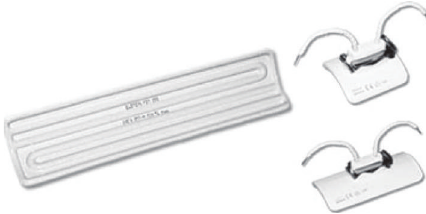
Figure 1: Ceramic heater.